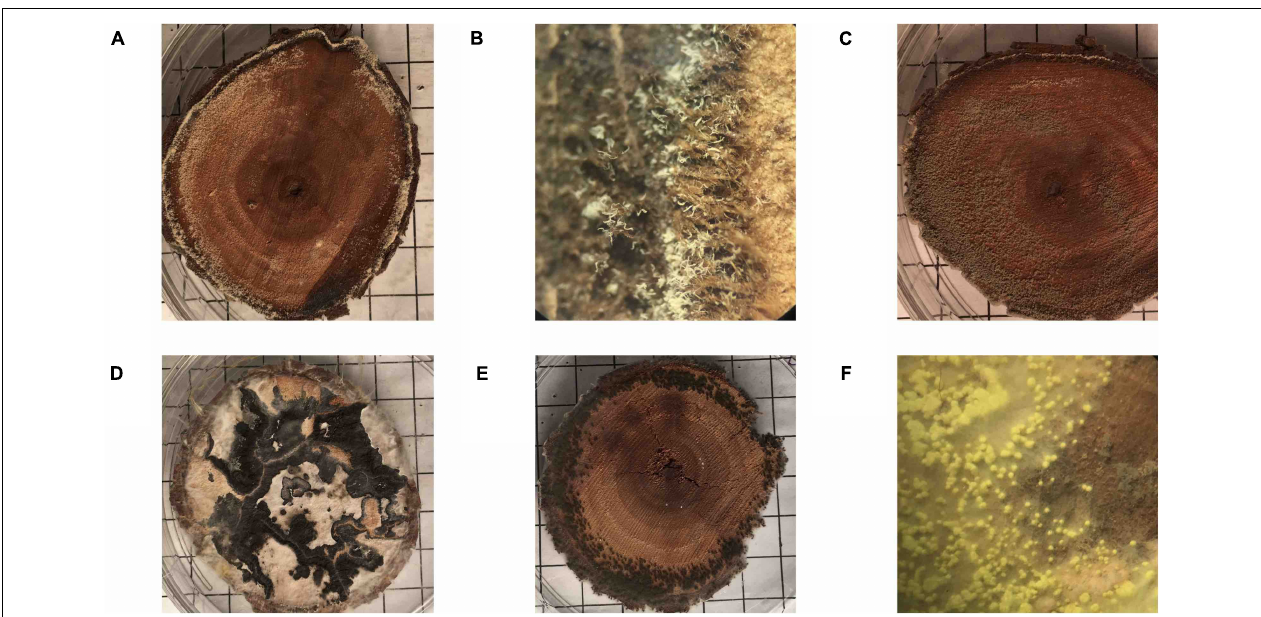
FIGURE 1 | Representative images of wood disks colonized by fungi from Experiments 1 (A,C–E) and 4 (B,F) . Wood disk colonized by Geosmithia morbida (A,B) , Aspergillus sp. and G. morbida (C) , Xylariaceae sp. (D) , Trichoderma sp. (E) , and Aspergillus (both anamorph and Eurotium sexual stage) sp. and Clonostachys sp. (F) Each grid line is 1 cm 2 (A,C–E)